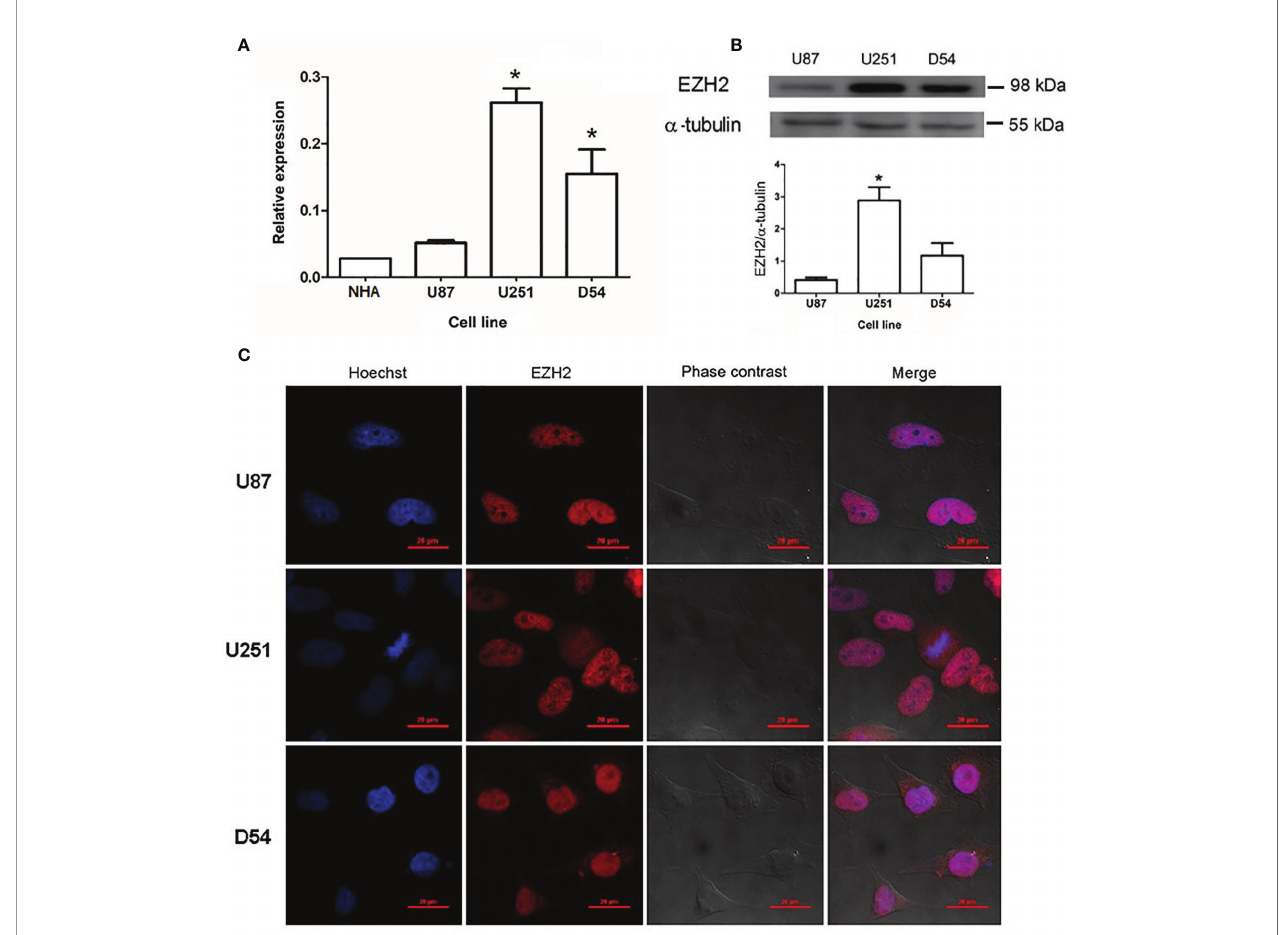
FIGURE 1 | Expression of EZH2 at mRNA and protein levels in human GBM-derived cells. (A) RT-qPCR quanti fi ed the amount of EZH2 mRNA (normalized to 18S ribosomal RNA using the comparative 2 DD Ct method) in normal human astrocytes (NHA) and U87, U251, and D54 cell lines cultured under basal conditions. *p < 0.05 vs . U87 and NHA. Each bar represents the mean ± S.E.M., n = 3. (B) EZH2 content was determined by Western blot in U87, U251, and D54 cell line, using a -tubulin as a loading control. Representative blot image and the corresponding densitometric analysis for EZH2 content in human GBM-derived cells. *p < 0.05 vs . U87 and D54. Bars represent the mean ± S.E.M., n=3. (C) Subcellular localization of EZH2 in GBM cell lines. Representative images of immuno fl uorescence showed that EZH2 is mainly found in the nuclei. Images were captured at 100X ampli fi cation. Red scale bars = 20 m